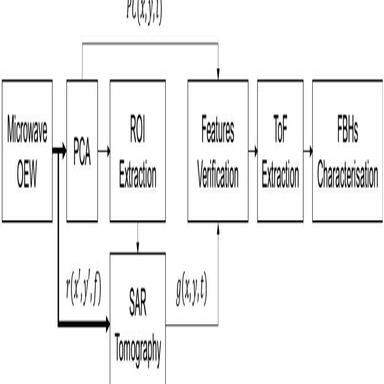
A block diagram for feature extraction of impact damage.